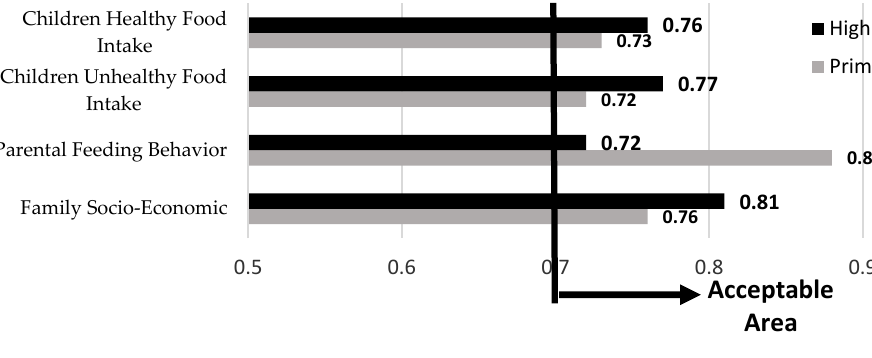
Figure 6. Cronbach’s alpha outputs.